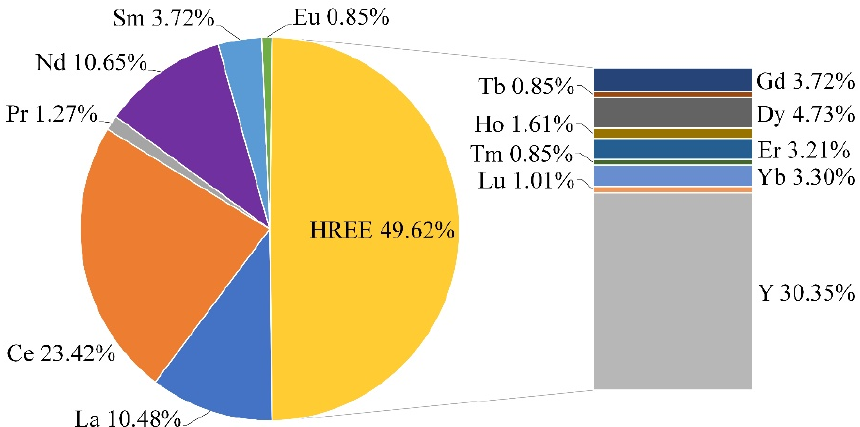
Figure 3. Distribution of individual rare earth elements in non-magnetic fraction.